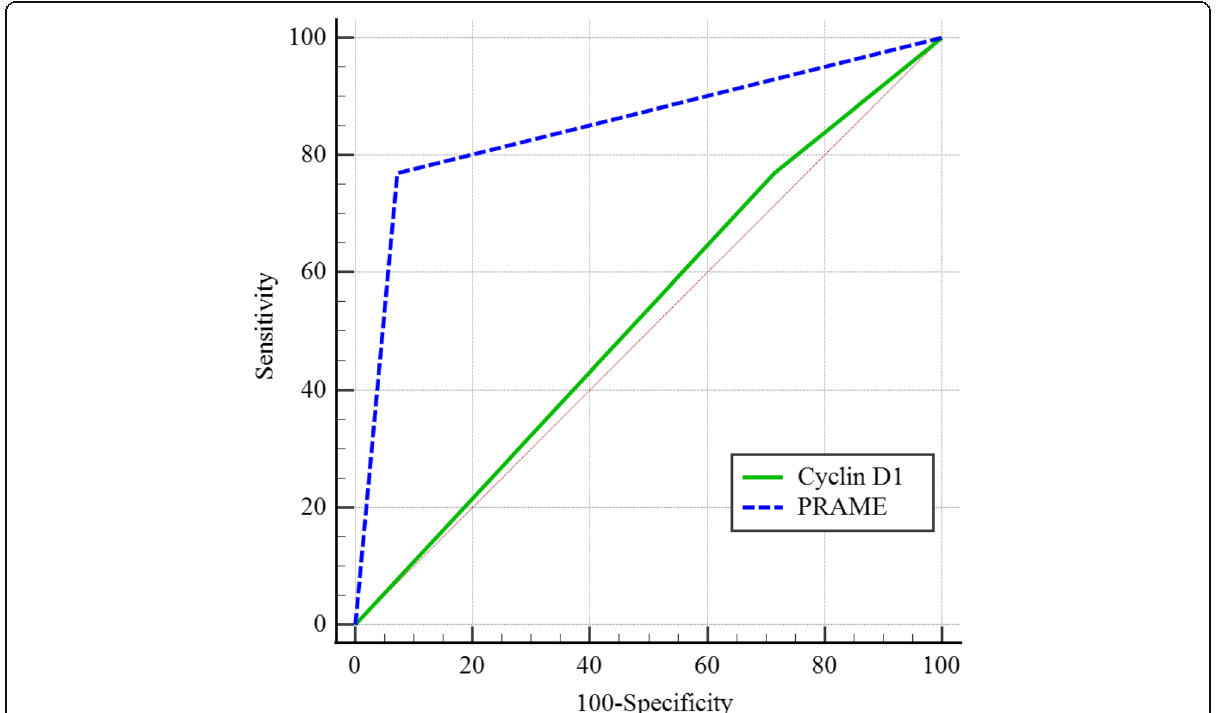
Fig. 3 Receiver Operating Characteristic (ROC) curve for discriminating subungual MIS from benign SMP based on the expression levels of Cyclin D1 and PRAME. Using the cutoff of 92.5%, with > 92.5% nuclear immunostaining for cyclin D1 as a positive test for subungual MIS, cyclin D1 showed poor overall discrimination between benign SMP and subungual MIS (AUC = 0.527, 95% CI = 0.328 – 0.721). Using the cutoff of 10%, with > 10% nuclear immunostaining for PRAME as a positive test for subungual MIS, PRAME exhibited good overall discrimination between benign SMP and subungual MIS (AUC = 0.849, 95% CI = 0.659 –